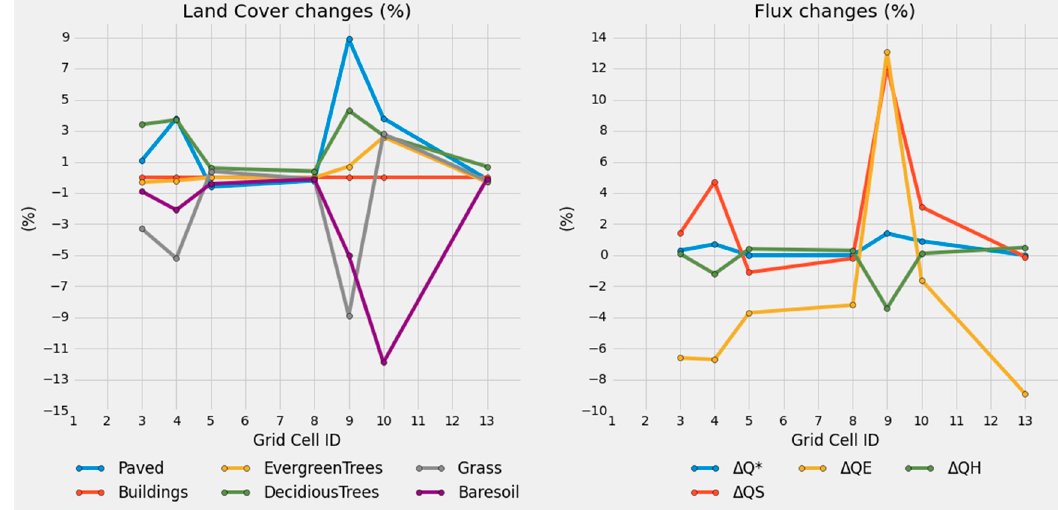
Figure 12. Land cover changes (%) and UEB components’ changes (%) per grid cell.